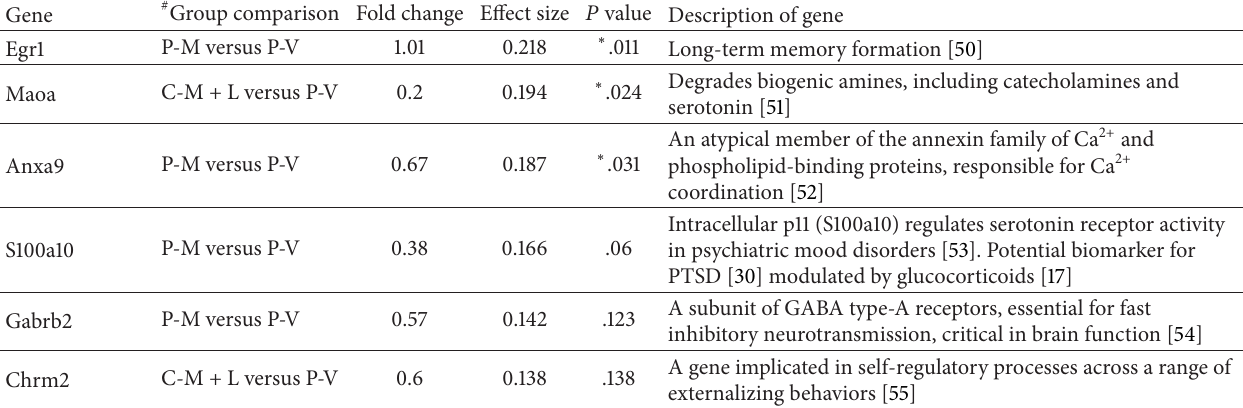
Table 2: Between-group changes in gene expression within the hippocampus.